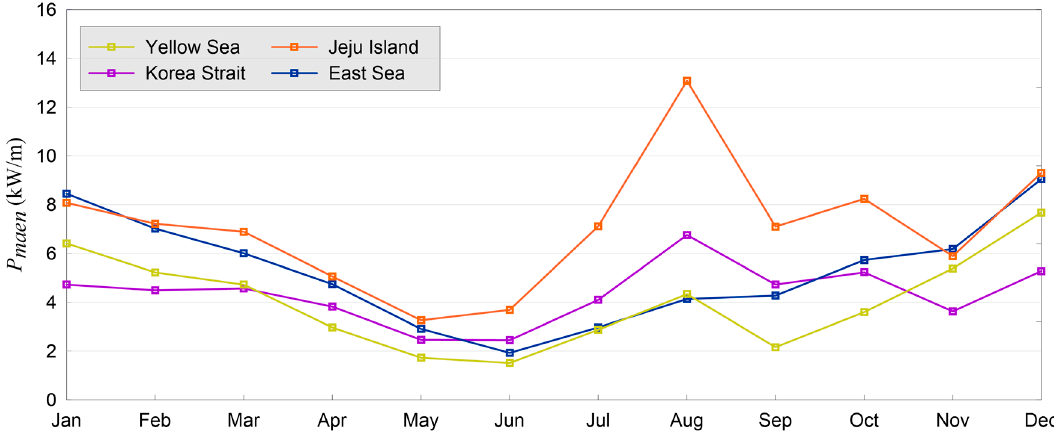
Figure 10. Monthly wave power in the Yellow Sea, Korea Strait, East Sea, and Jeju Island averaged over 12 years from 2007 to 2018.